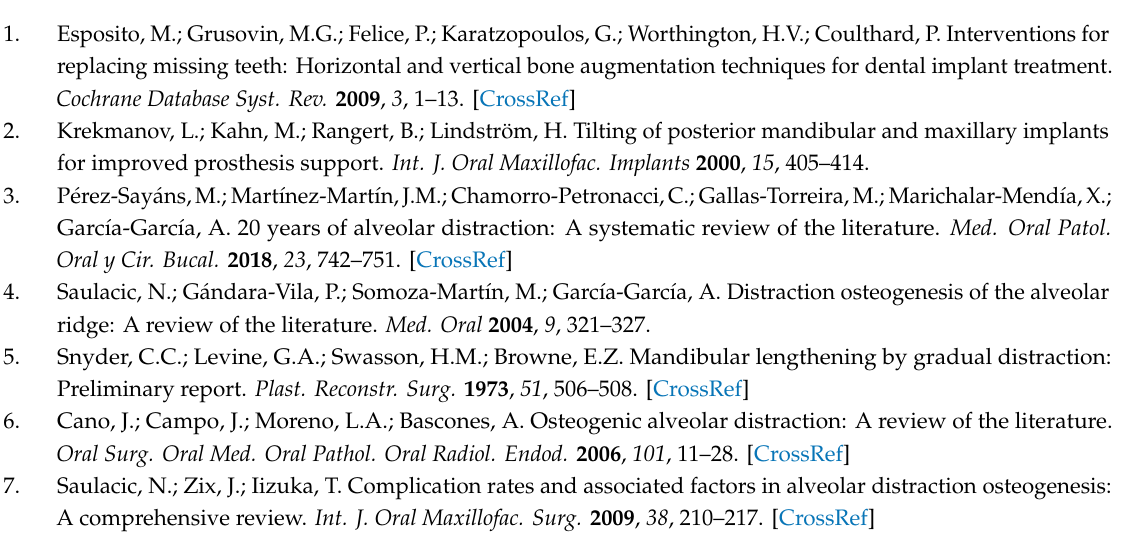
Table S1: Most common complications in VAOD, prevention and treatment. Table S2: PRISMA 2009 Checklist. Table S3: Indication and location for